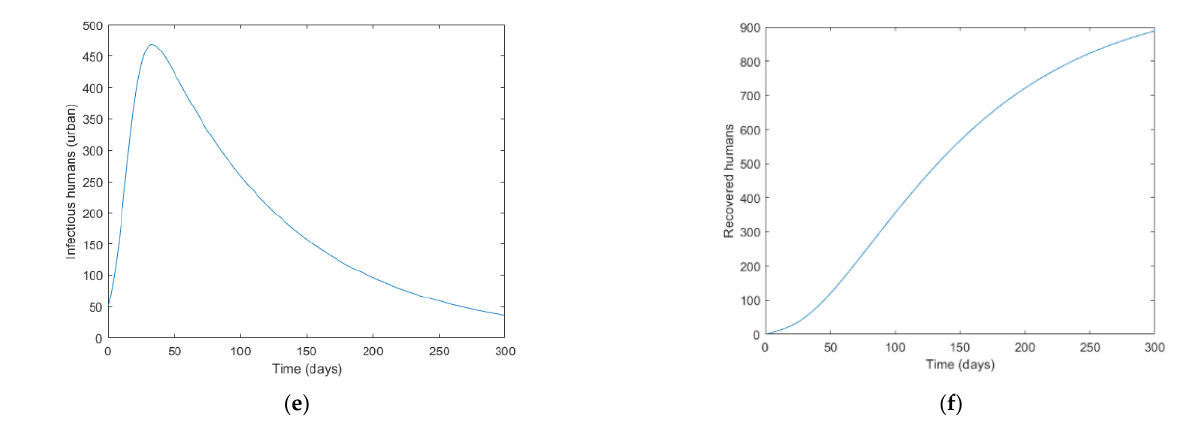
Figure 1. Numerical simulation for the endemic equilibrium case with the parameters shown in Table 1 and parameters of Equation (1). ( a ) Susceptible individuals S; ( b ) Exposed individuals (rural) E h ; ( c ) Exposed individuals (urban) E l ; ( d ) Infected individuals (rural) I h ; ( e ) Infected individuals (urban) I l ; ( f ) Recovered individuals R . Table 2. The epidemiological parameters used in Equation